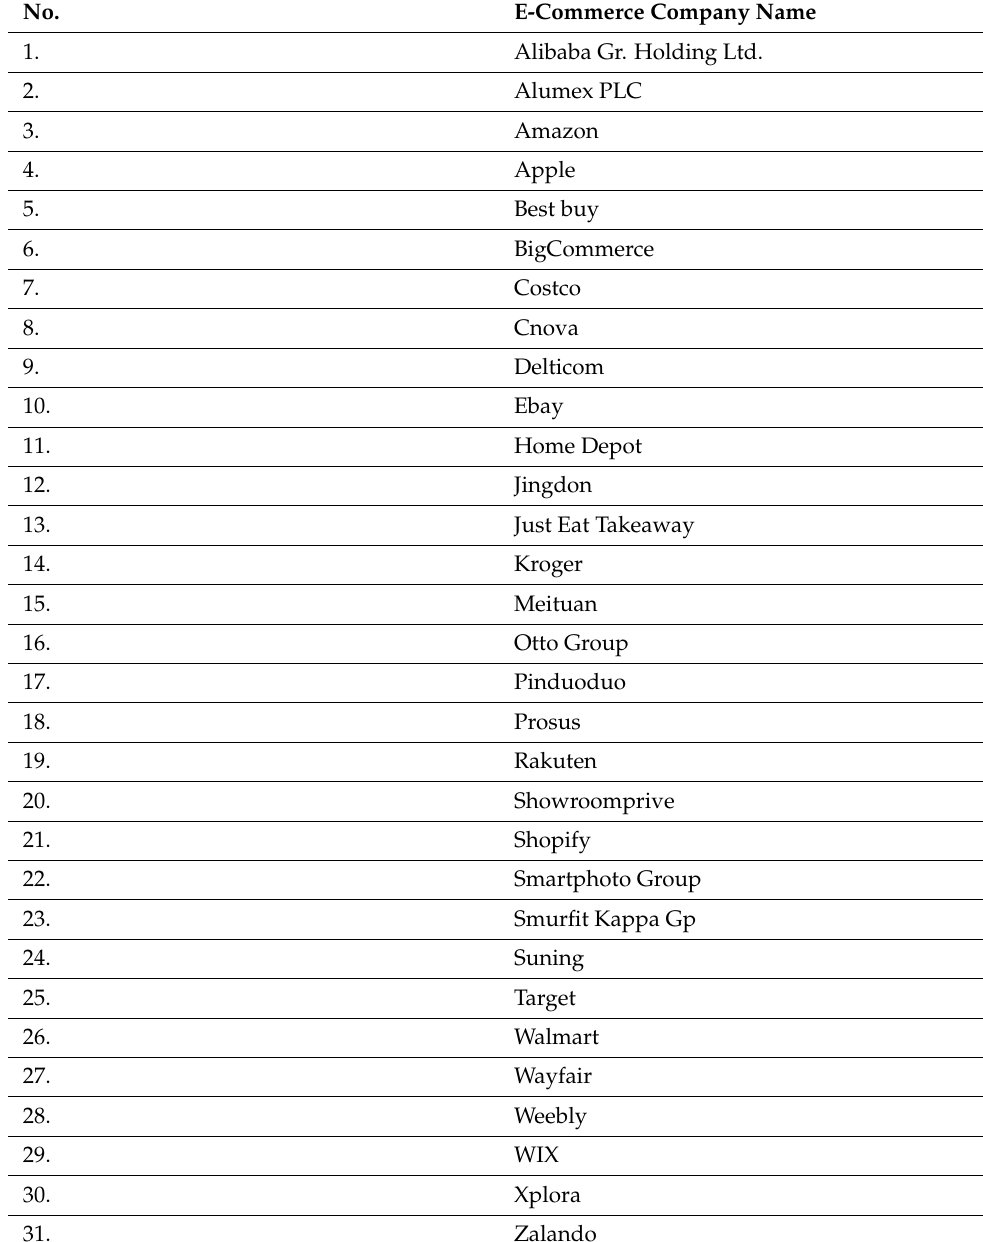
Table A1. List of companies used in the analysis of